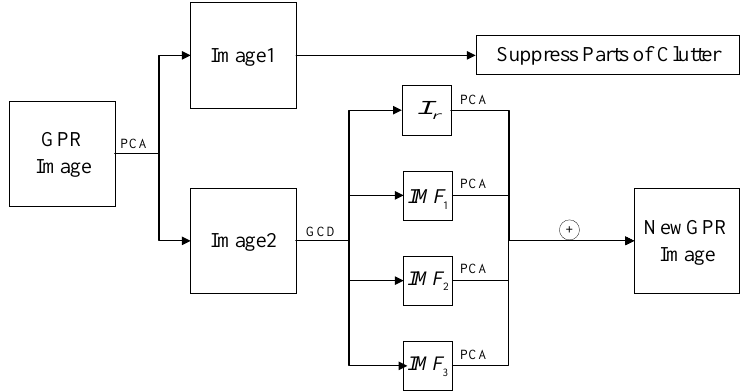
Figure 4. Flow chart of PCGCD-based clutter suppression